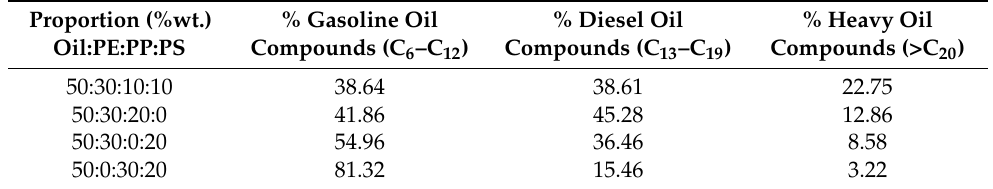
Table 8. Proportion of compounds with different numbers of carbon atoms in the co-pyrolysis products. Proportion